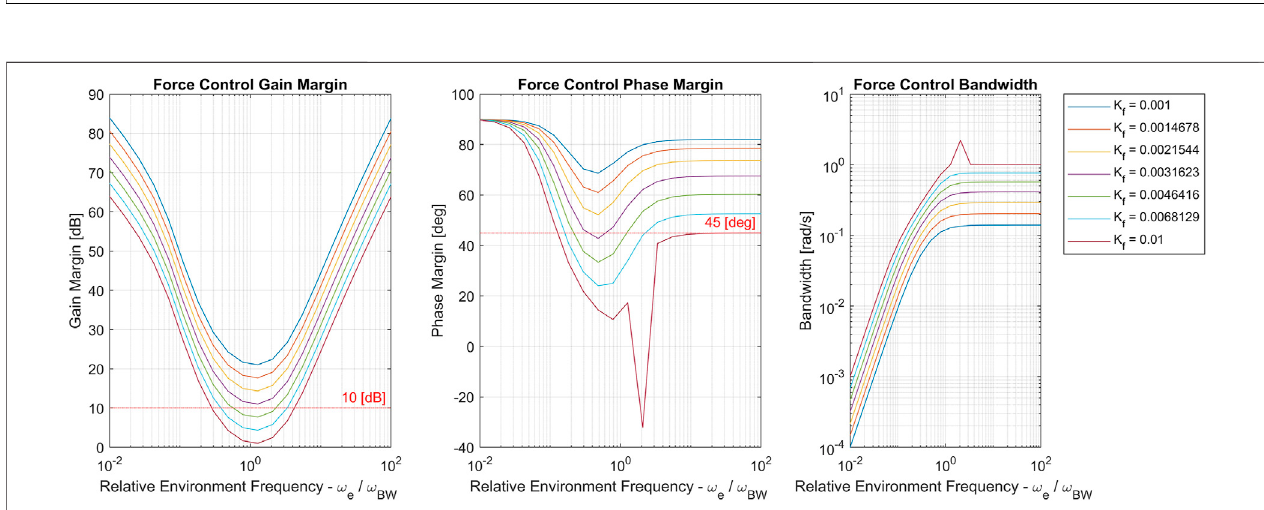
FIGURE14| Forcecontrolgainmargin,phasemarginandbandwidthforthenominalsystemwithdifferentvaluesof ω e ∈ {0.01,100}(sampledevenlyinlog-space). Separate curves corresponds to different values of K f . Note that the discontinuity in the K f (cid:2) 0.01 curve is due to its proximity to instability.